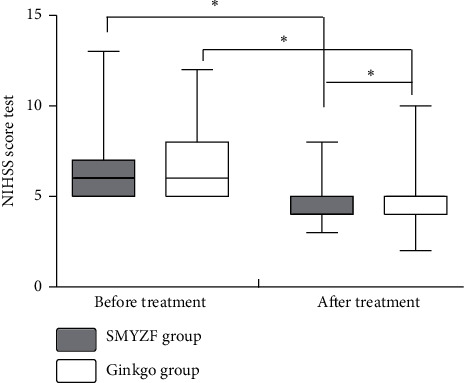
Comparison of NIHSS scores in the 2 groups. Note: ∗significant effect (P < 0.05).